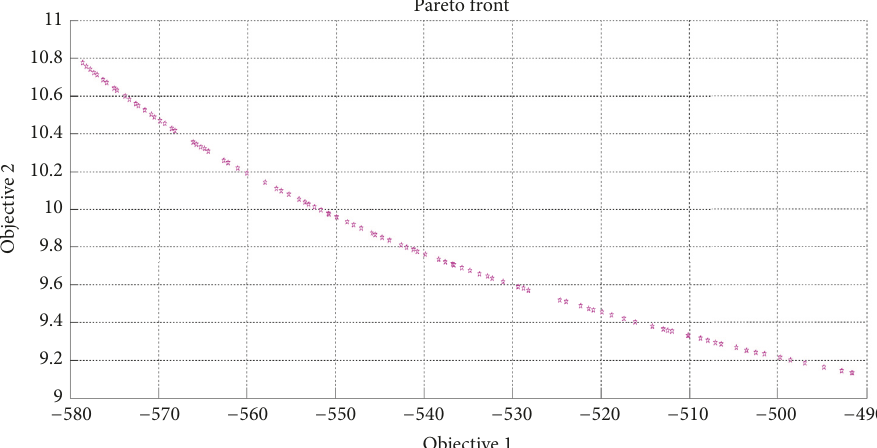
Figure 6: The Pareto solutions obtained by the NSGA-II